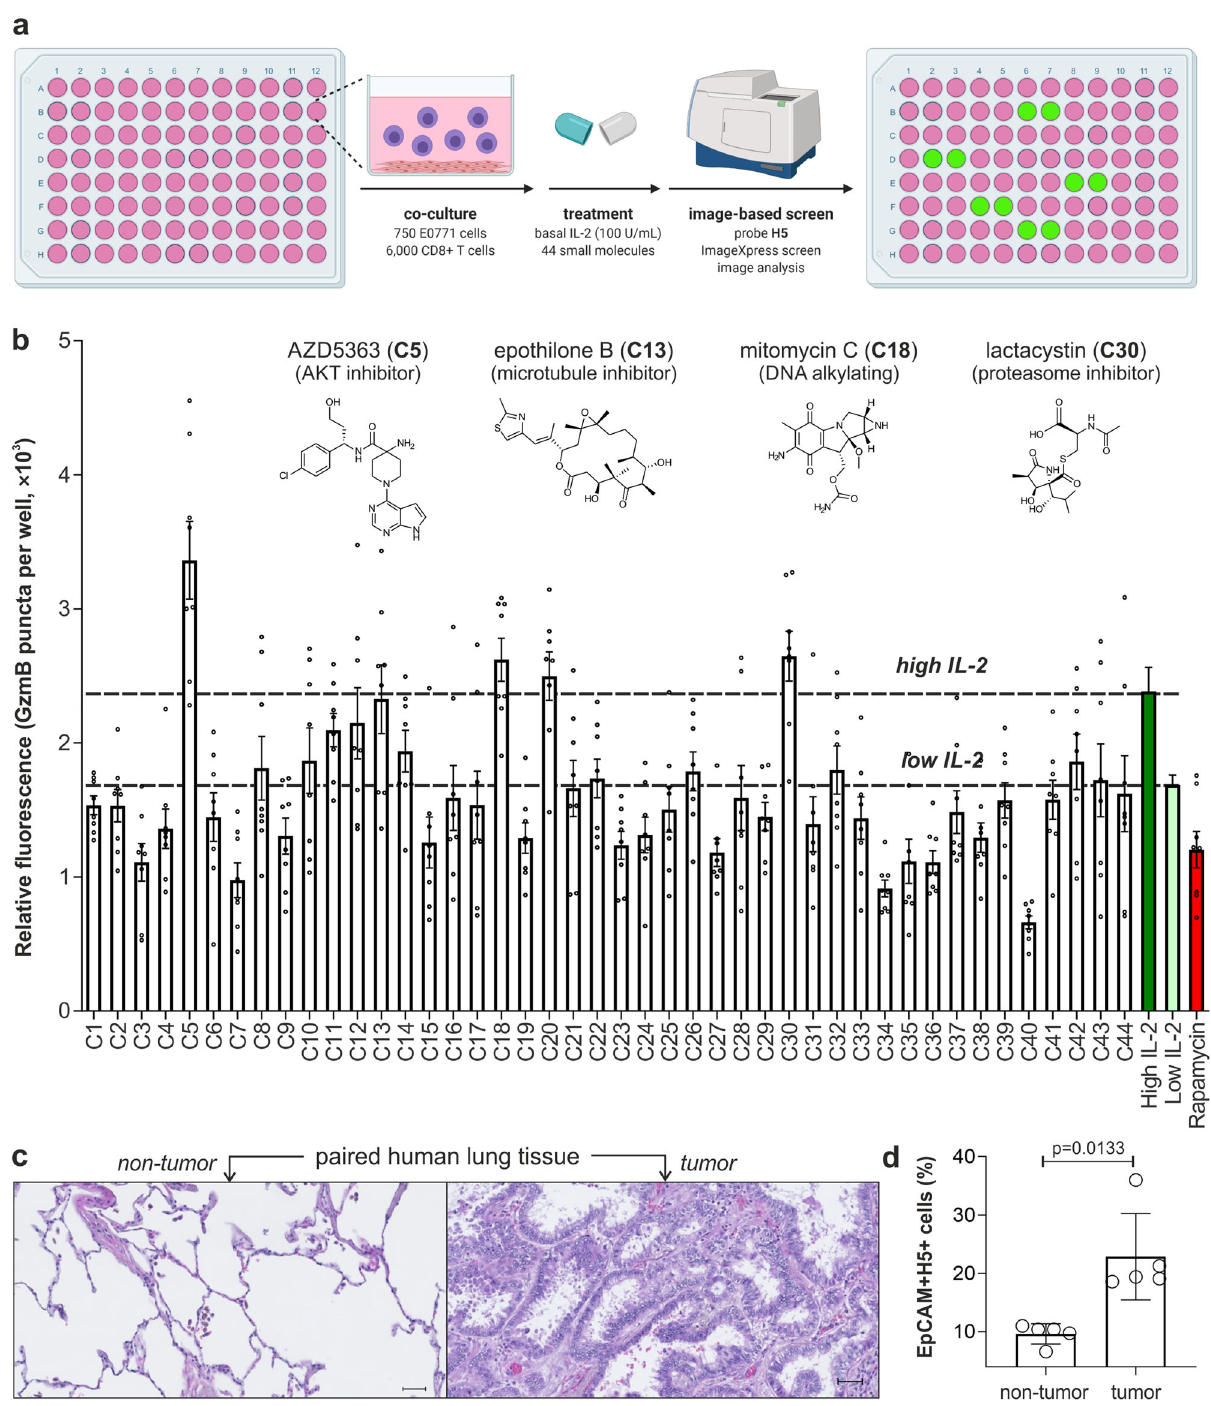
Fig. 4 Probe H5 detects immunomodulatory action in phenotypic screens and T cell cytotoxic activity in human tissue from lung cancer patients. a Experimental protocol of the phenotypic screen. b Fluorescence intensity of probe H5 in co-cultures of E0771 cells and IL-2-activated CD8 + T cells after incubation with small molecules (C1-C44). Wells received 100 U mL − 1 IL-2 (low IL-2) for T cell viability. High IL-2 (250 U mL − 1 ) used as a positive control for invigorated CD8 + T cells and rapamycin (0.3 μ M) used as a negative control. Probe H5 (20 μ M) and Hoechst 33342 (1 µ M) were incubated for 1 h and fl uorescence images were acquired with an ImageXpress TM XLS. Data as means ± SEM ( n = 8). Chemical structures of drugs showing H5 fl uorescence signals above those with 250 U mL − 1 IL-2. c Representative H&E microscope images of non-tumor (left) and lung adenocarcinoma (right) paired samples. Scale bar: 50 µ m. d Cytometry analysis (gating: Fig. S17) showing the percentage of EpCAM + H5 + epithelial cells found in paired tissues (non-tumor vs tumor) from lung cancer patients after incubation with probe H5 (5 μ M). Data as means ± SD ( n = 5). P -value from two-tailed t- tests. Source data ( b , d ) provided as a Source Data fi